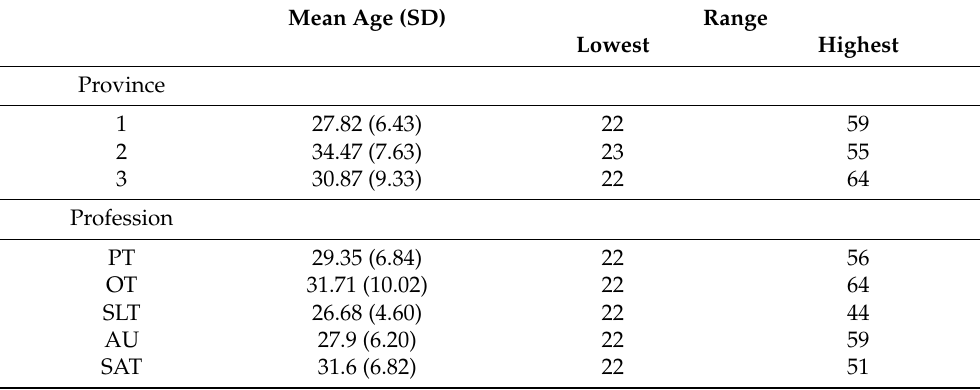
Table 2. Therapist ages according to province and profession, as derived from the web-based survey.